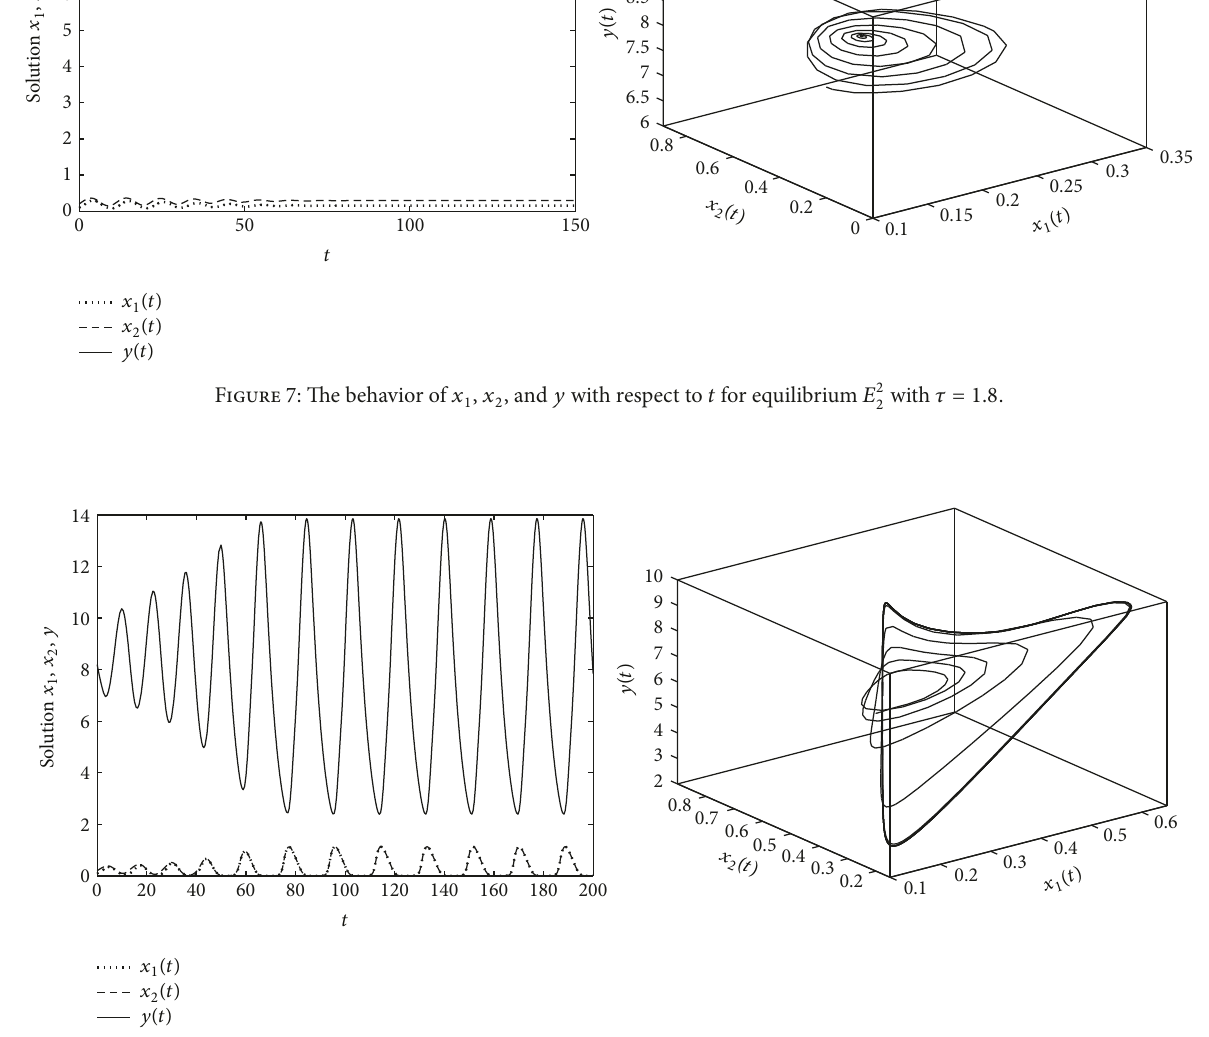
Figure 8: The behavior of 𝑥 1 , 𝑥 2 , and 𝑦 with respect to 𝑡 for equilibrium 𝐸 2 2 with 𝜏 = 2.6